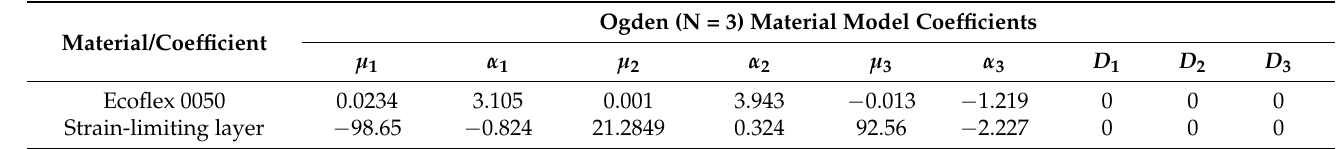
Table 1. The Ogden ( n = 3) material model constants for Ecoflex 00-50 and strain-limiting layer.